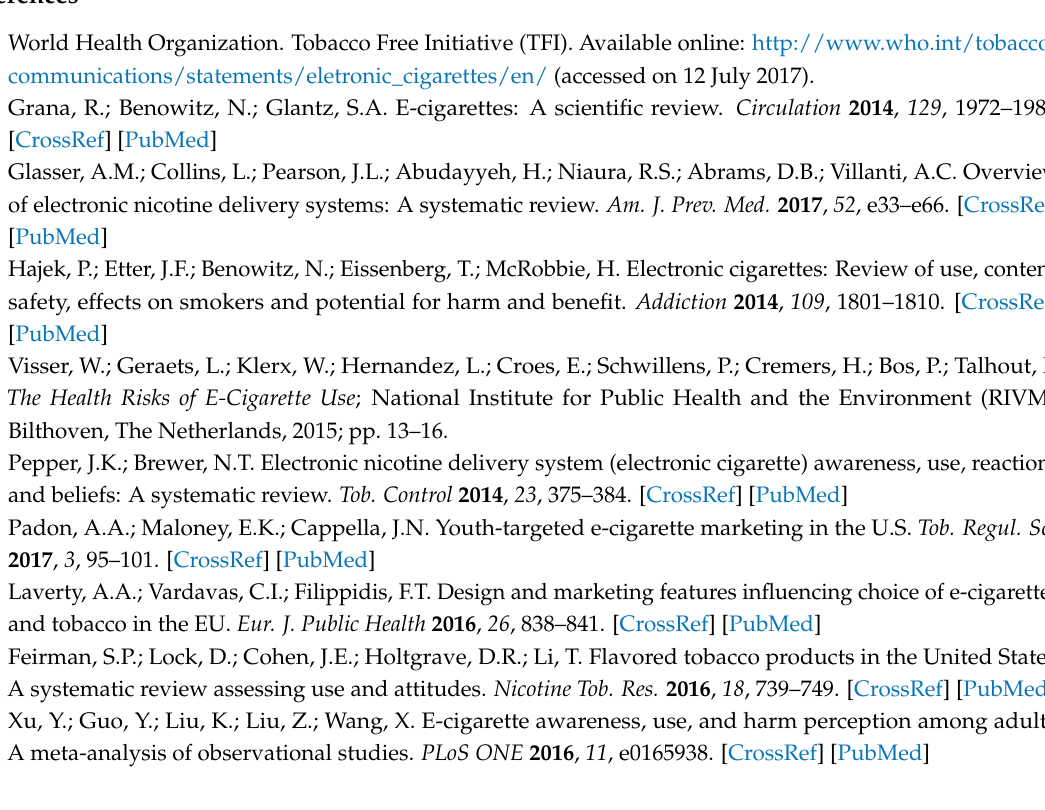
s1, Table S1: Search Strategy for OvidMedline ® _Original search, Table S2: Decision Tree of Exclusion Criteria, Table S3: Major Relevant Findings of Included